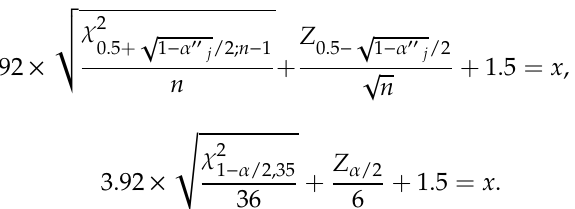
* = 3.81 and Q ∗ Q = 3.81 and * PUi 0 0 PUi